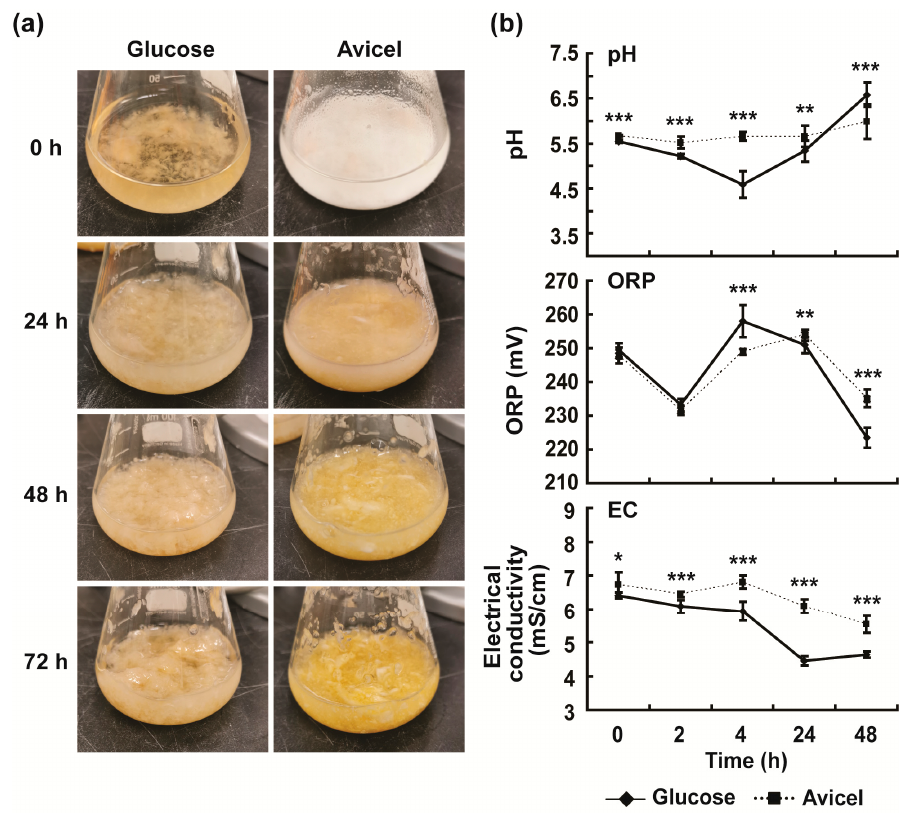
Figure 3. Physical and chemical properties of media during incubation. ( a ) Photographs of Neurospora crassa cultured in glucose or Avicel medium. ( b ) pH, ORP and EC of media. The media were harvested after 0, 2, 4, 24, 48, and 72 h. Each value represents the mean of 9 or 12 replicate measurements (three replicates per experiment and three or four independent experiments): * p < 0.05, ** p < 0.01, *** p < 0.001 as determined by Student’s t -test .